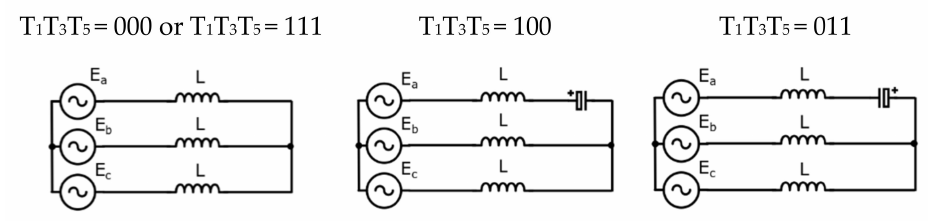
Figure 3. Equivalent configurations for the first